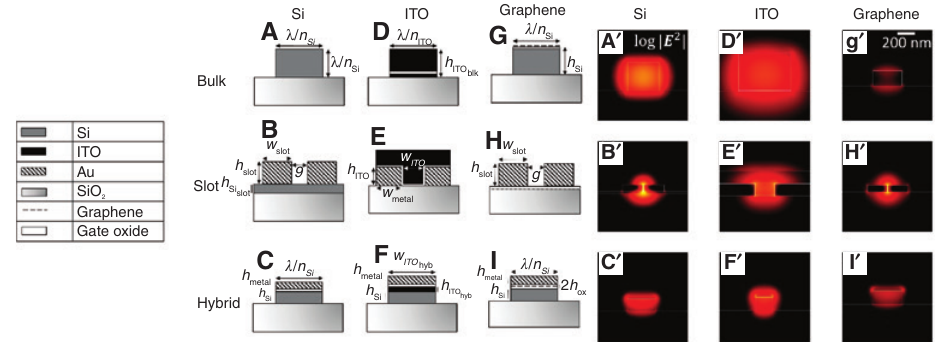
Figure 2: Schematic of the mode structures and FEM simulated mode profiles for all the structures at their respective starting point from the material dispersion at λ = 1550